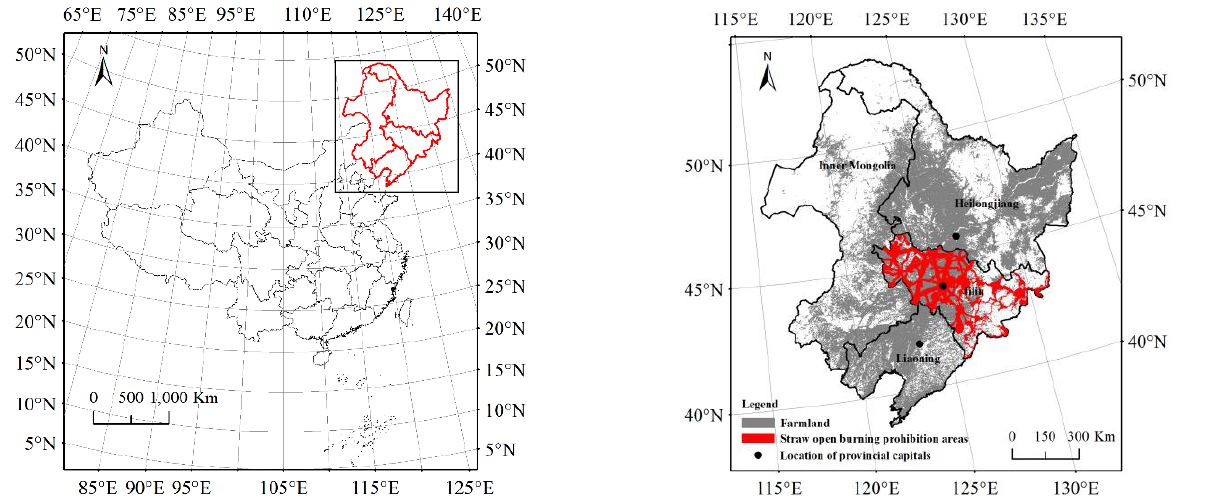
Figure 1. The location of Northeastern China ( left ) and the provinces (eastern Inner Mongolia, Liaoning, Jilin and Heilongjiang) mentioned in this study ( right ).